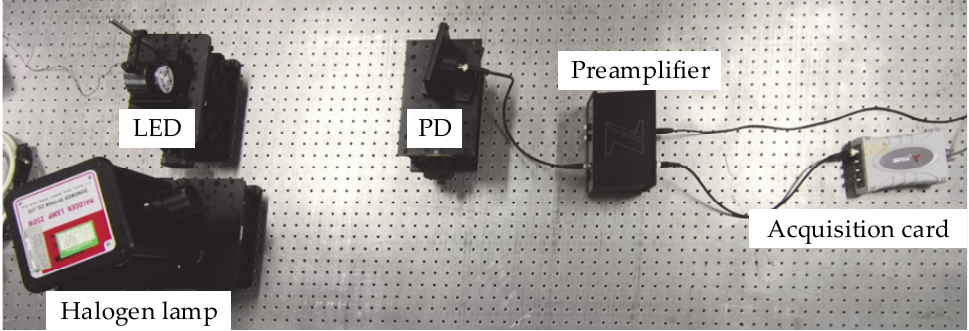
Figure 9. Device for measuring the stability of the calibration light source in real time.